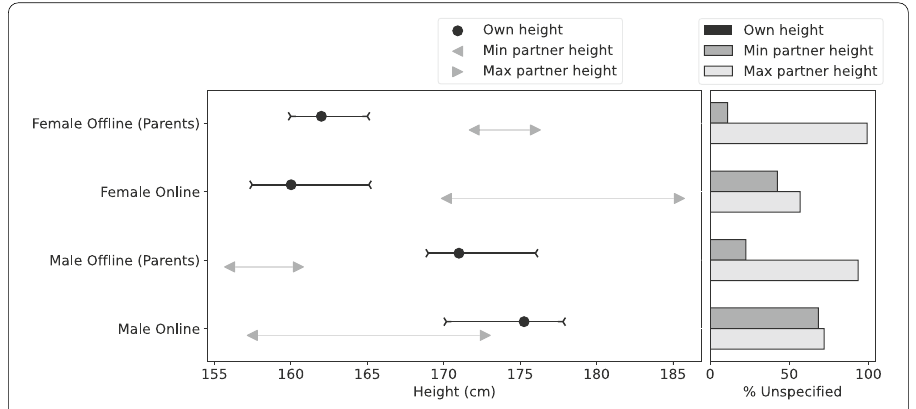
Fig. 2 LHS: Range of preferences for Partner Height as compared to Own Height (shown with mean and IQR). The subgroups displayed are grouped by gender and degree of parental involvement (online vs. offline sample). RHS: The proportion of profiles that did not specify Own Height or Min/Max Partner